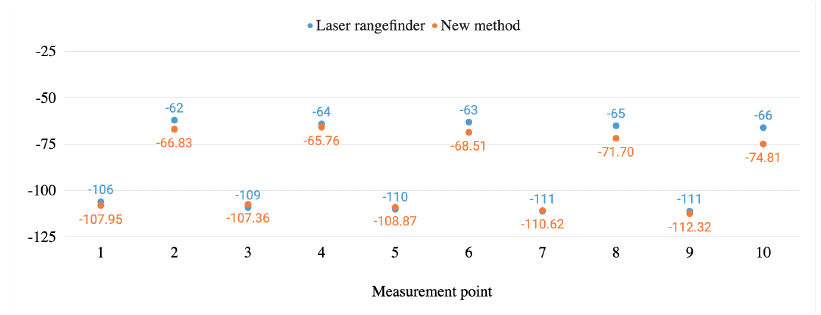
Figure 14. Stagger measurements’ comparison between the new method and the laser rangefinder in the test bench